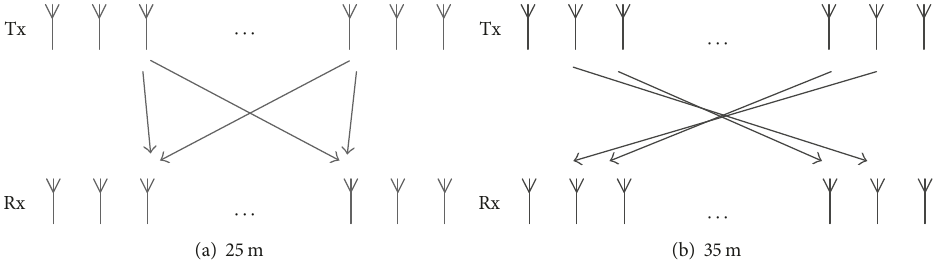
Figure 16: Illustrations of the two propagation modes at 25 m and 35 m based upon the amplitude matrices.